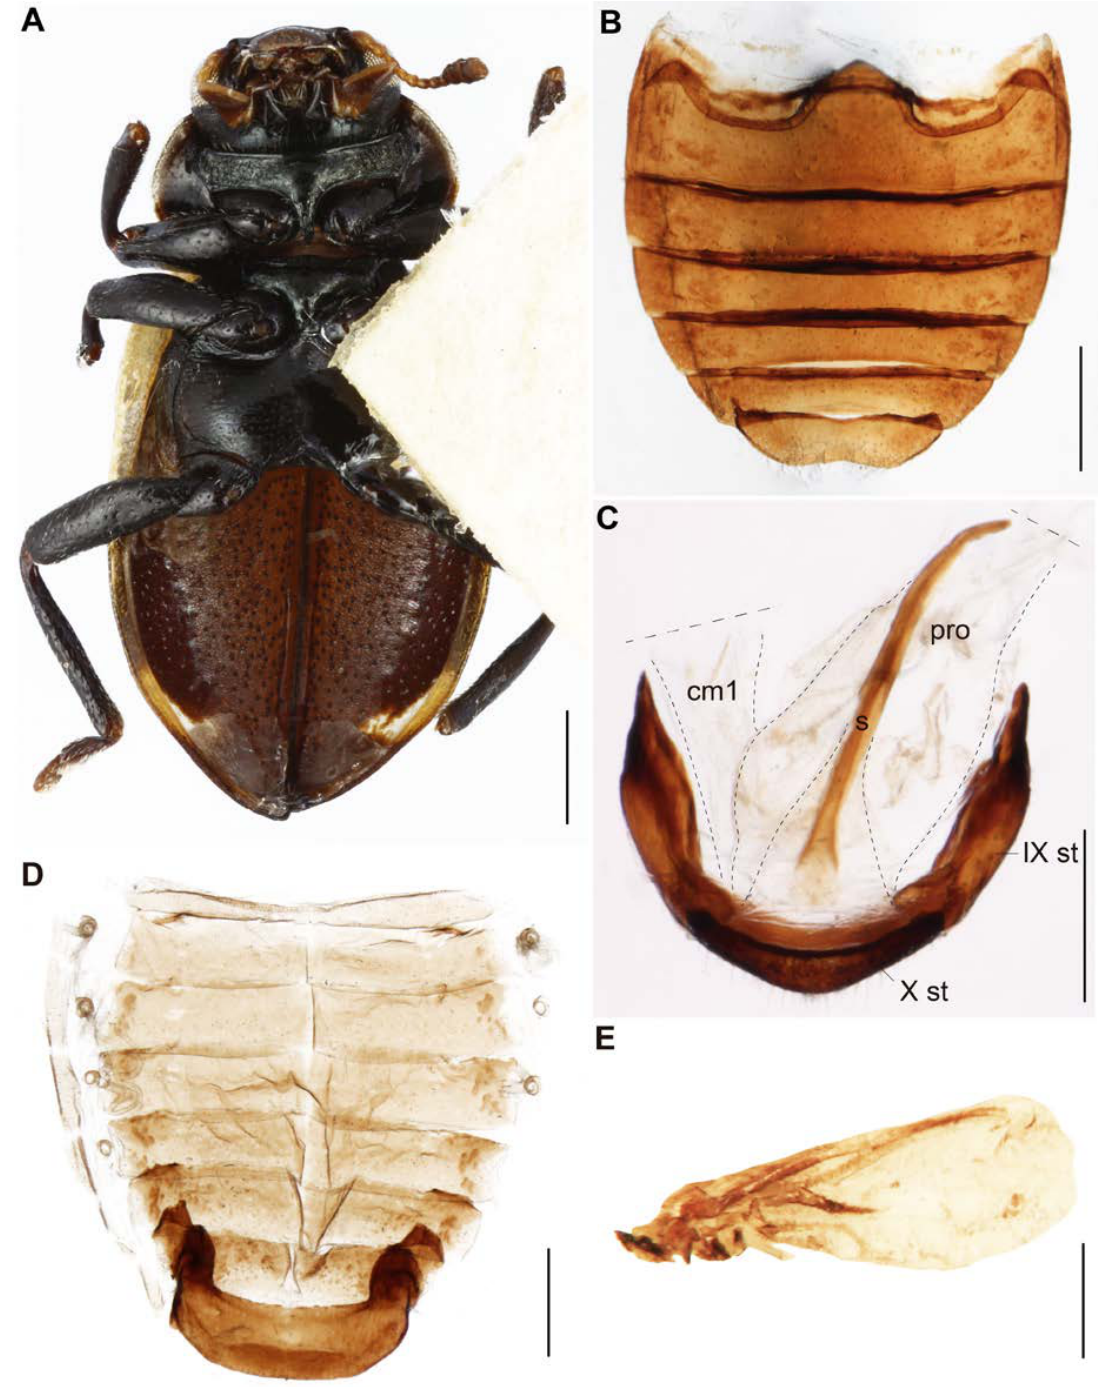
Figure 3. Eriopis patagonia Salazar, sp. nov. —Holotype. ( A ). In ventral view. ( B , C ). Sternites (st) III–VIII ( B ) and IX–X ( C ). ( D ). Tergites. cm1: connective membrane 1; pro: proctodeum; s: spicule. ( E ). Left hindwing. Dotted lines in ( C ) indicate membrane structures. Scale bars (mm): ( A , B , D ) 0.5; ( C , E ) 0.25.